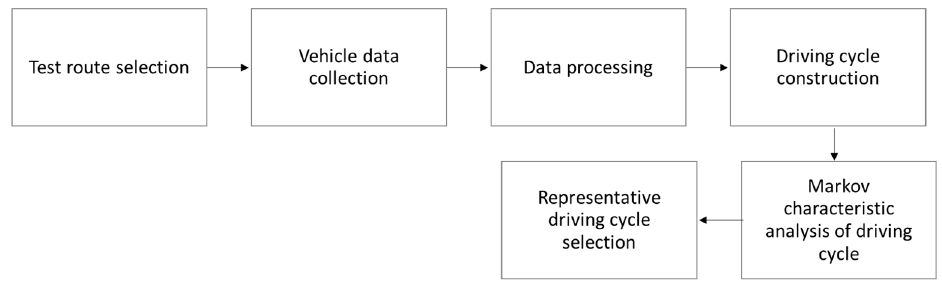
Figure 12. Overview of EV clustering based on soft clustering proposed in [70].